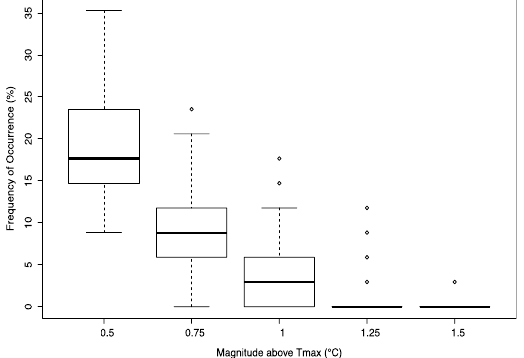
Figure 5. Probability, as the frequency of occurrence between 1982–2015, of maximum annual temperature (T max ) anomalies of different magnitudes. A Kruskal-Wallis test and post-hoc Dunn’s tests found significantly different frequencies among and between all anomalies (Kruskal-Wallis, p < 2.2 e − 16 , chi-squared = 2674, df = 4; all Dunn’s tests, p < 0.05, Z range = [4:44]).